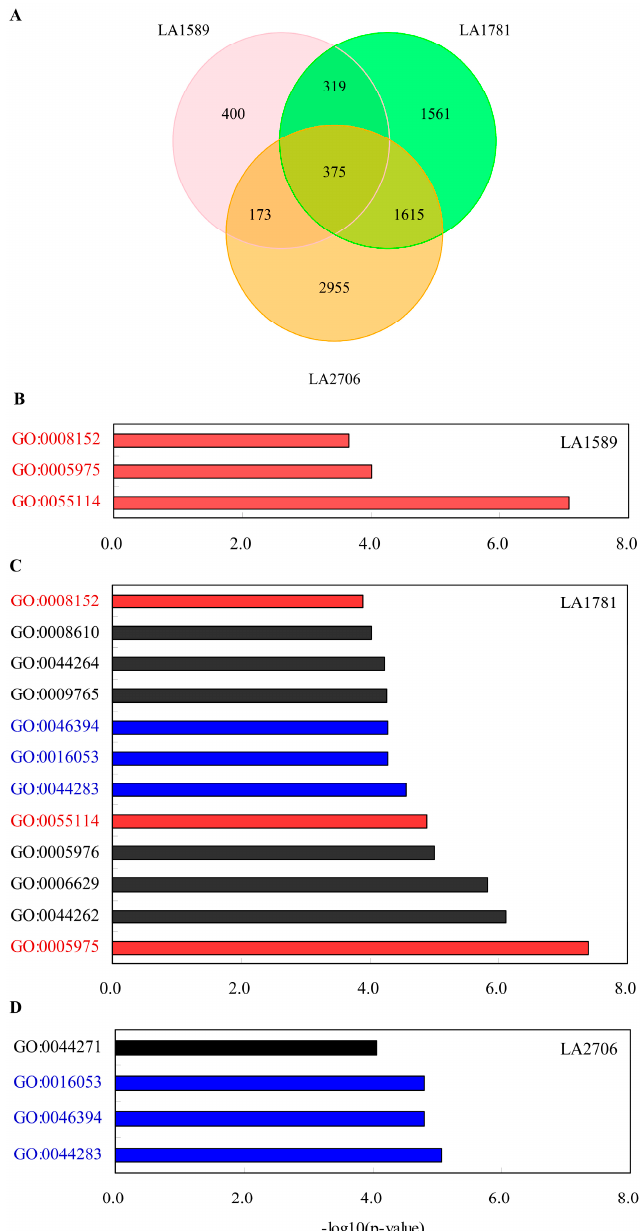
Figure 3. Gene ontology analysis of differentially expressed genes between GH and PH conditions. ( A ) Venn diagram of genes showing differential expression in response to different growth conditions; ( B – D ) Gene Ontology term analysis of genes responding to different growth conditions in LA1589 ( B ); LA1781 ( C ) and LA2706 ( D ), respectively. Enriched GO terms (adjusted p -value < 0.05) include carbohydrate metabolism (GO:0005975), cellular carbohydrate metabolism (GO:0044262), lipid metabolism (GO:0006629), polysaccharide metabolism (GO:0005976), oxidation reduction (GO:0055114), small molecule biosynthesis (GO:0044283), organic acid biosynthesis (GO:0016053), carboxylic acid biosynthesis (GO:0046394), photosynthesis, light harvesting (GO:0009765), cellular polysaccharide metabolism (GO:0044264), lipid biosynthesis (GO:0008610), metabolism (GO:0008152), and cellular nitrogen compound biosynthesis (GO:0044271). Shared GO terms between genotypes were highlighted in red or blue and those not shared were in black.